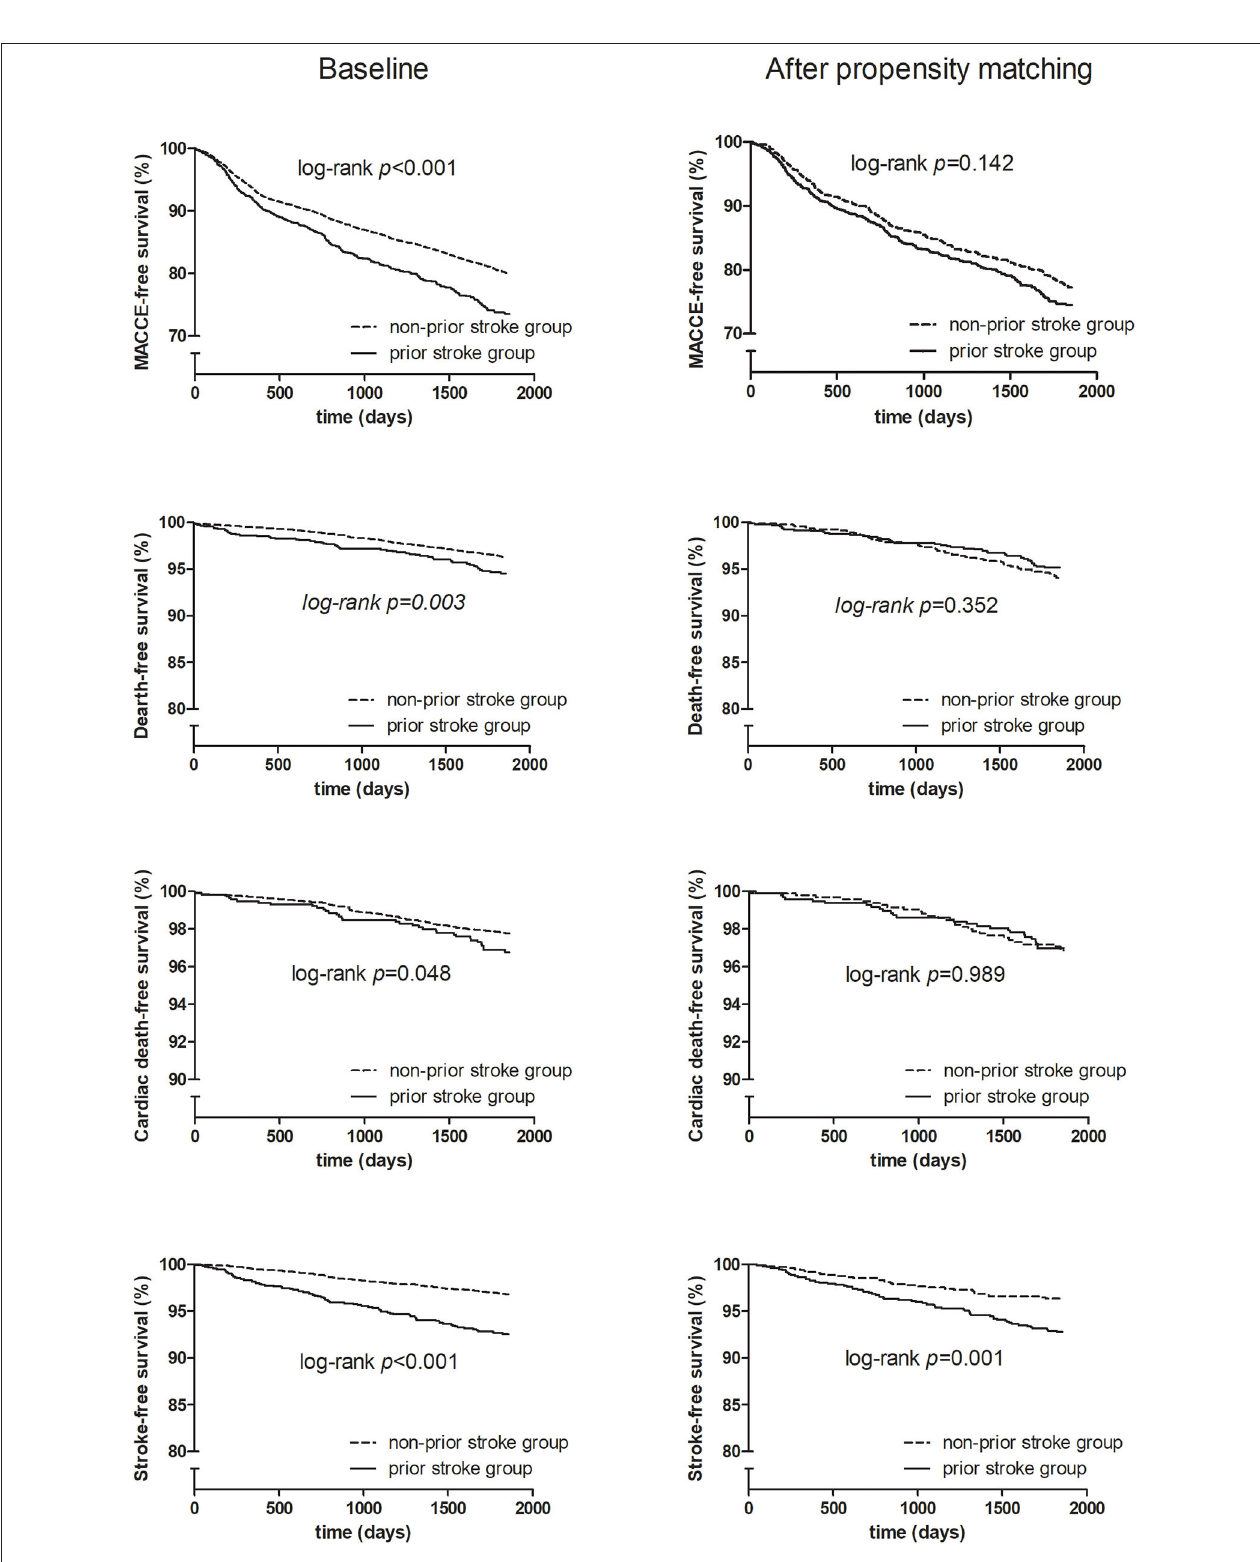
FIGURE 2 | Kaplan–Meier survival curve for baseline and propensity score matching.